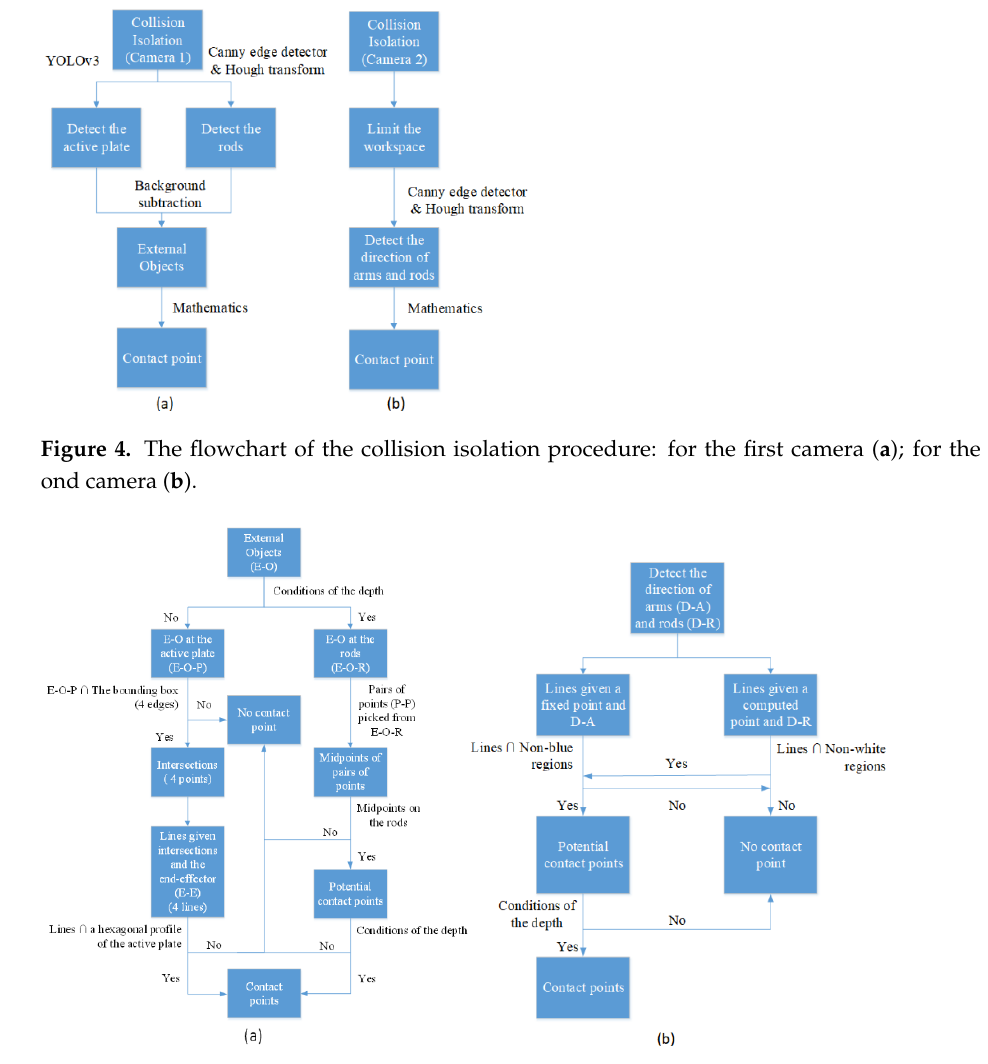
Figure 5. The flowchart of the mathematics processing for the first camera ( a ); the second camera ( b ).